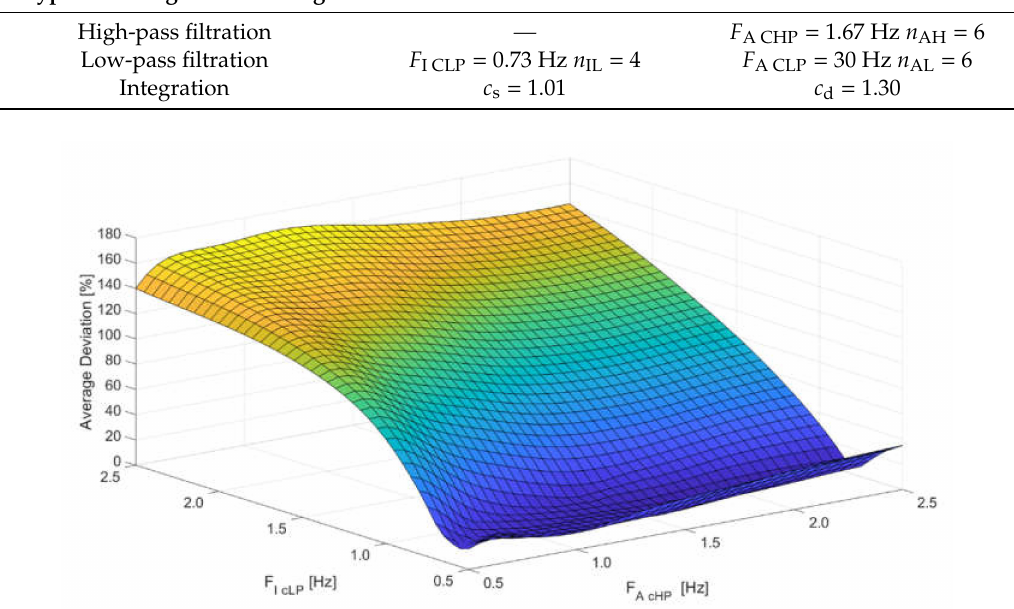
Figure 9. The distribution of average deviation at di ff erent cut-o ff frequencies of the F I CLP low-pass filter signal from inclinometers and the F A CHP high-pass filter signal from the